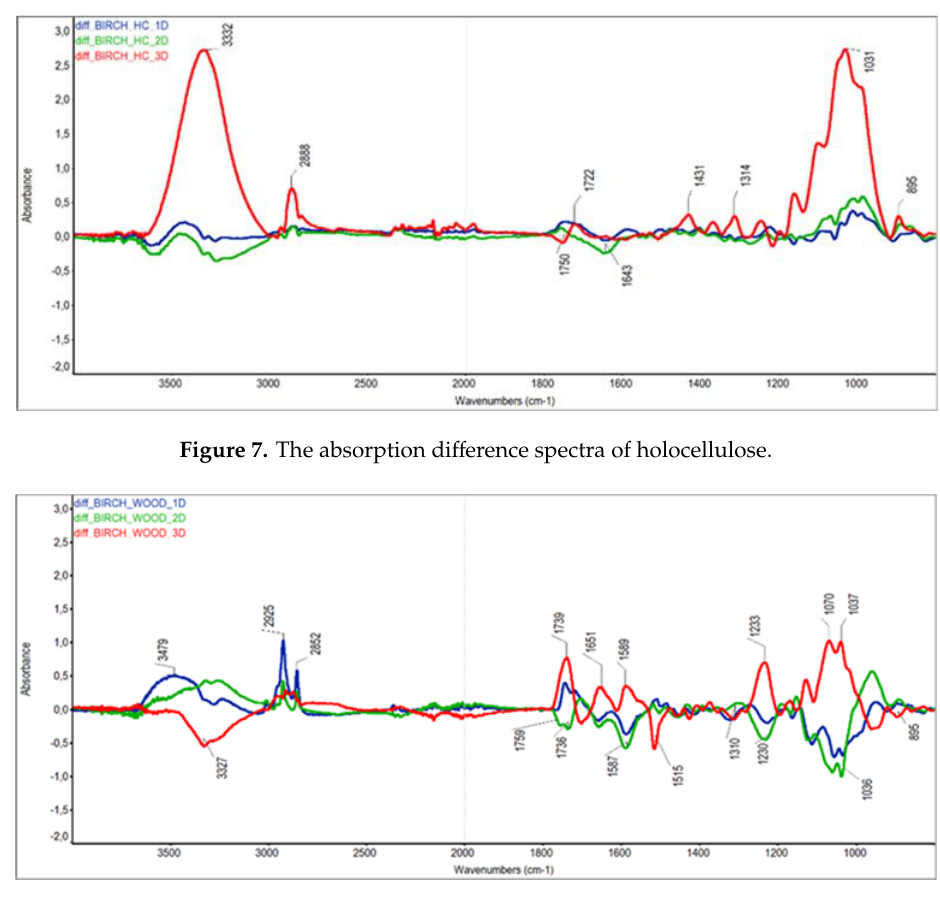
Table 2. Absorbance ratios H 1732/2900 and H 1243/2900 .